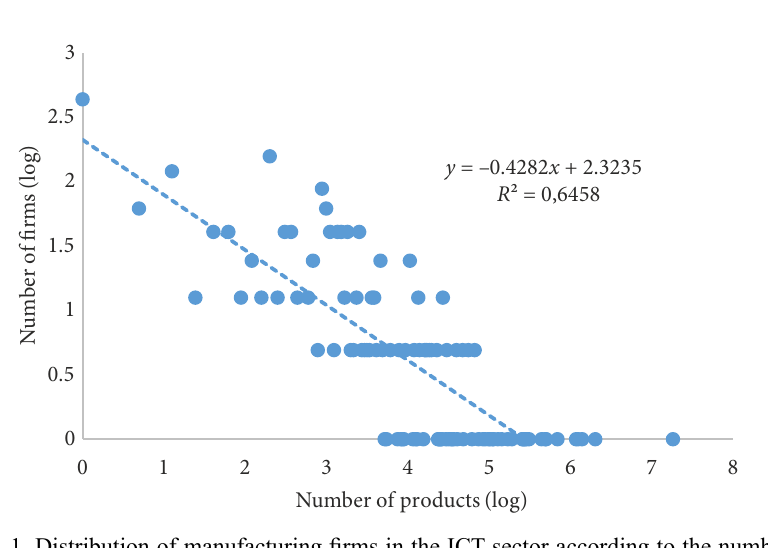
Fig. 1. Distribution of manufacturing firms in the ICT sector according to the number of intermediate inputs that firms import. In the figure a dot denotes the number of firms importing a given number of intermediate inputs Source : authors’ calculation based on data from SCB.